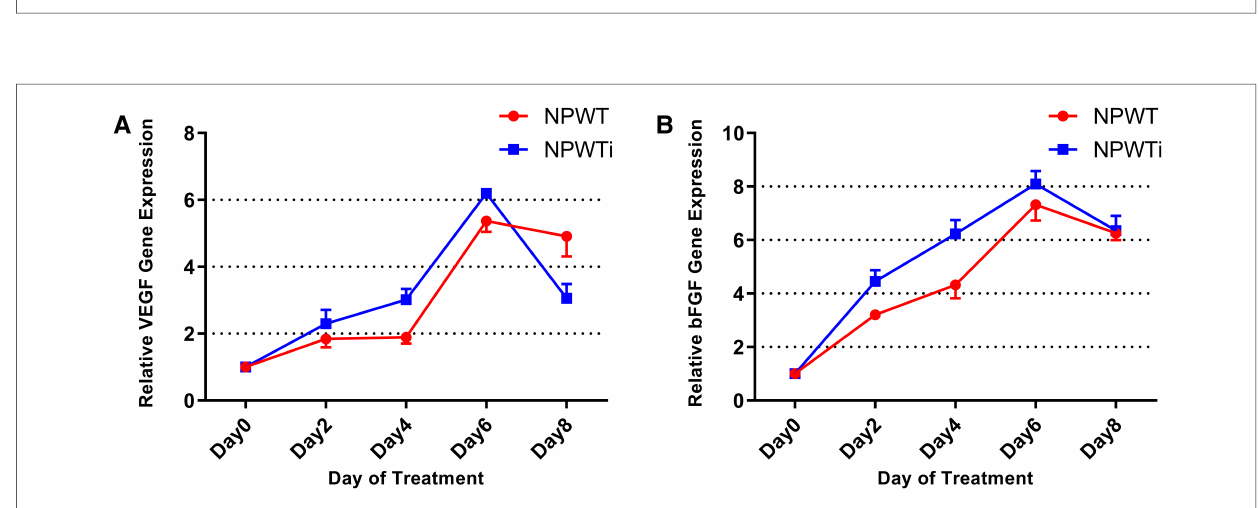
FIGURE 6 ( A ) the difference in VEGF expression. ( B ) The difference of bFGF expression. Expression levels of VEGF and bFGF on postoperative day 2, 4, and 6, were signi fi cantly higher in the NPWTi group than in that of the NPWT group ( P <0.05) (fold